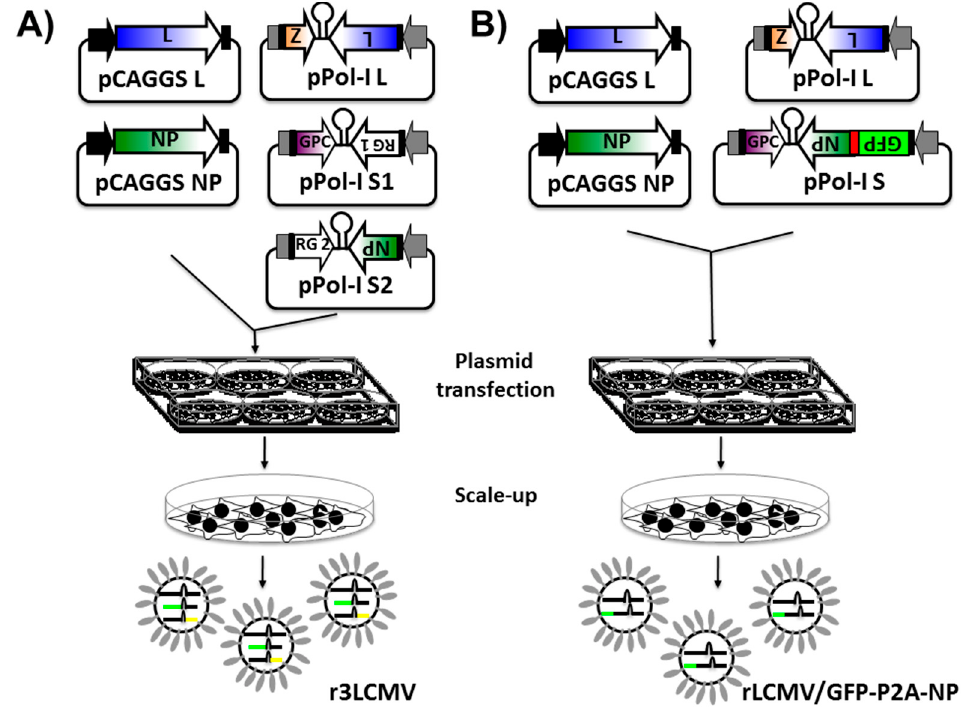
Figure 3. Generation of recombinant replicating competent reporter-expressing arenavirus: Arenavirus rescues are performed in rodent (using the mouse Pol-I promoter) or in human (using the human Pol-I promoter) cells in six-well plates. Alternatively, arenavirus rescues can be performed in T7-expressing cells using plasmids driving the expression of the arenaviral S and L segments under the T7 promoter. ( A ) Generation of r3 arenaviruses: Cells are transiently co-transfected, using LPF2000, with the pCAGGS protein expression plasmids encoding the viral NP and polymerase L (required to initiate viral gene transcription and genome replication) together with the pPol-I vRNA expression plasmids for the viral L segment and the two (pPol-I S1 and pPol-I S2) viral S segments. In the pPol-I S1 plasmid, the viral NP is replaced by a reporter gene 1 (RG 1), and, in the pPol-I S2 plasmid, the reporter gene 2 (RG 2) replaces the viral GPC. Alternatively, the viral NP can be replaced by RG 2 and the viral GPC by RG 1 (Figure 4A,B, respectively). At 72 h post-transfection, cells are trypsinized and scaled-up into 10 cm dishes. After an additional 72 h incubation period, presence of virus is determined by RG expression. R3 arenaviruses typically encode for two RGs, such as fluorescent or luminescent proteins (Table 1). In such cases, successful viral rescue and viral titers can be evaluated under a fluorescent microscope (i.e., fluorescent protein expression). Alternatively, a luciferase assay can be used to evaluate the presence of virus from tissue culture supernatant; ( B ) Generation of recombinant bicistronic arenaviruses: to rescue rLCMV/GFP-P2A-NP, susceptible cells are transiently co-transfected with the pCAGGS NP and L plasmids, together with the pPol-I vRNA expression plasmids encoding the L segment and the modified S segment encoding GFP-P2A-GFP (Figure 4C). At 72 h post-transfection, cells are trypsinized and scaled-up into 10 cm dishes. After an additional 72 h, presence of rLCMV/GFP-P2A-NP is determined by green fluorescent protein (GFP) expression. The chicken beta-actin promoter (black arrow) and the rabbit beta-globin polyadenylation (pA) signal (black boxes) are indicated in the pCAGGS protein expression plasmids. Viral untranslated regions (UTR, black boxes) and intergenic regions (IGR) in the pPol-I vRNA expression plasmid are indicated. The Pol-I promoter and terminator sequences in the pPol-I plasmids are indicated by gray arrows and boxes, respectively. The red box ( B ) indicates the porcine teschovirus (PTV1) 2A peptide sequence. For more details, see text.